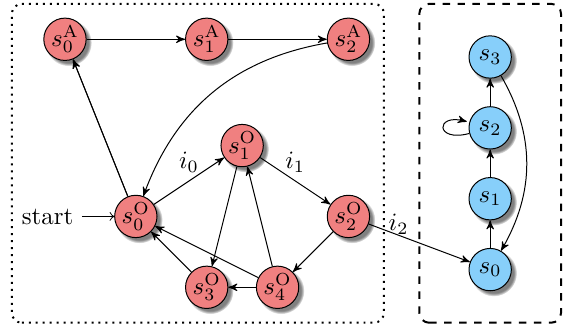
Figure 4: HARPOON design methodology example. The original FSM (dashed blue part) is augmented by an obfuscation mode s O , s A . The enabling key to reach the original initial state s 0 is ( i 0 , i 1 , i 2 s A , s A 1 2 0